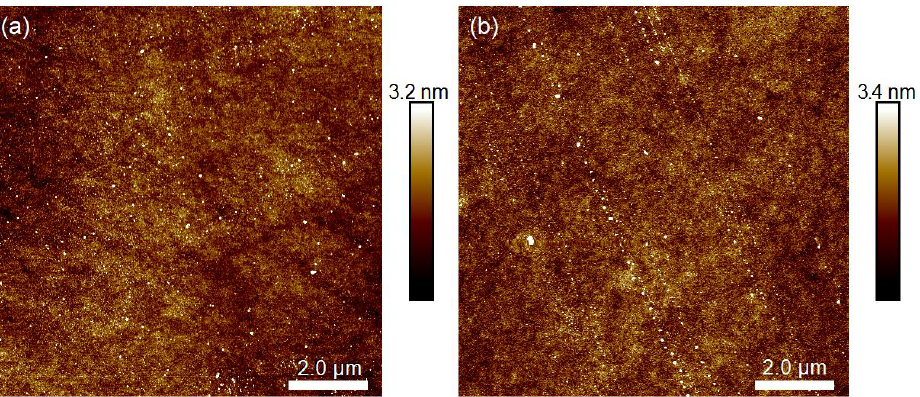
Figure 3. ( a ) Relief of the layer deposited by co-evaporation of GeO 2 and SiO 2 powders, ( b ) relief of the layer deposited by evaporation of SiO powder. Image size for both 2D AFM topography images is 10 µm × 10 µm.